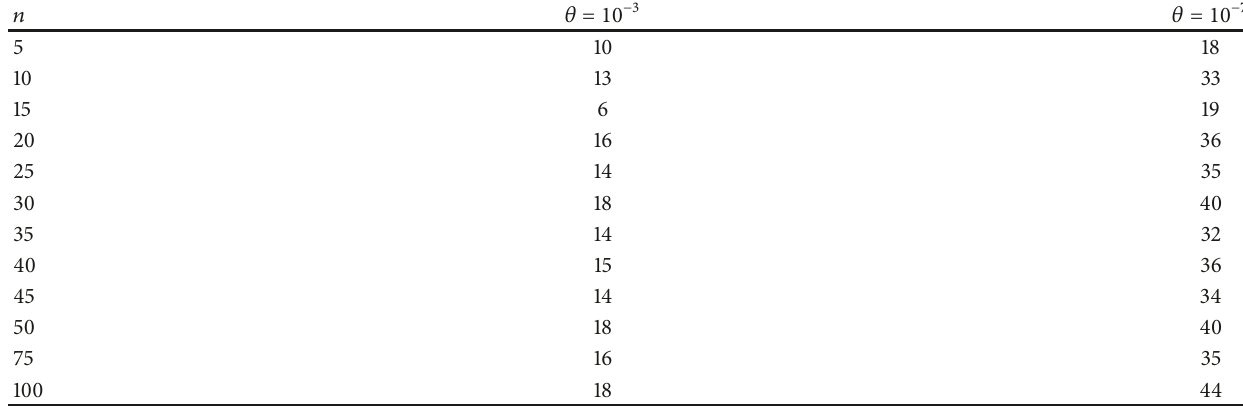
Table 4: Iterations needed in interval steepest descend method solving random linear interval systems.